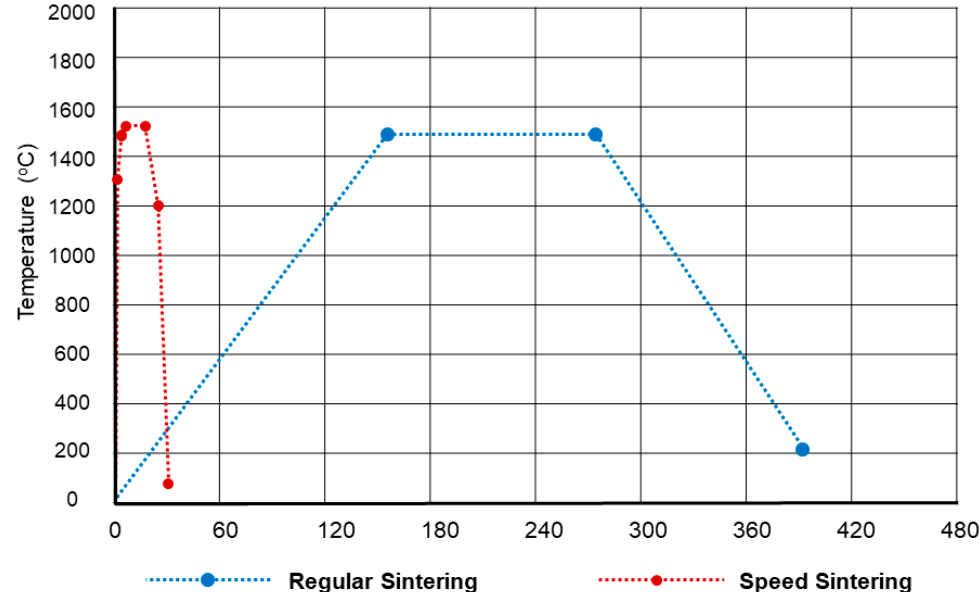
Figure 4. Total thermal cycle, sintering time, and dwell temperature for the regular and speed sin- tering.